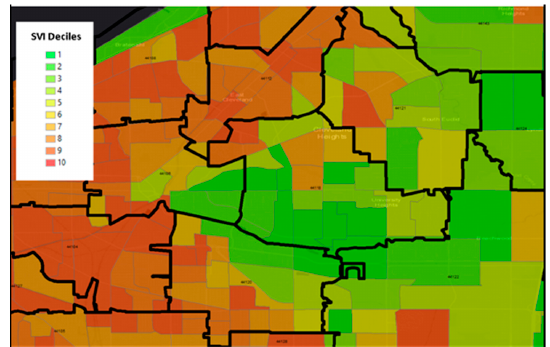
Figure 1. Example of zip code (black outline) vs. census tract (green = low social vulnerability to red = high social vulnerability). CDC Social Vulnerability Index (SVI) is represented as census tracts classified by deciles (green = low social vulnerability to red = high social vulnerability) and zip codes are represented with black outlines.